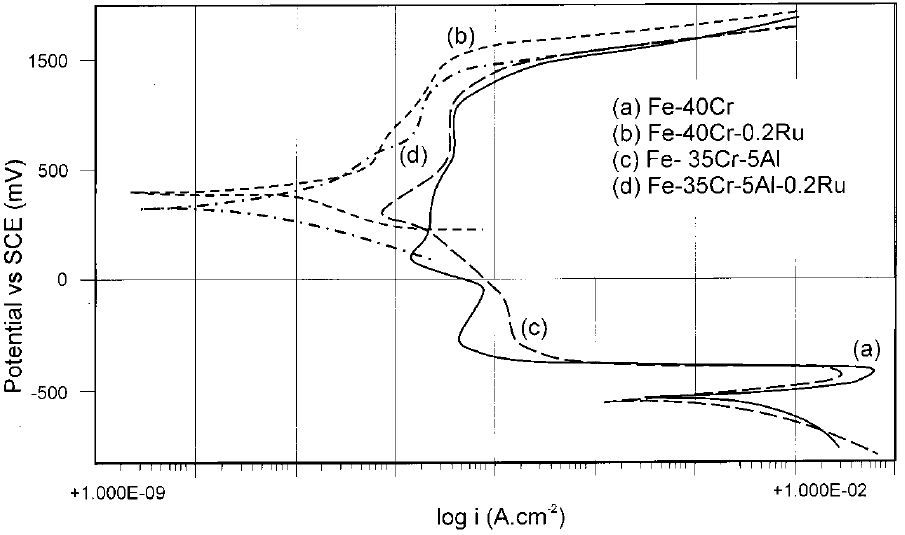
Figure 7. Potentiodynamic scans in 10% H 2 SO 4 at 25 °C of Fe-40Cr alloy in comparison to an alloy where Cr is partially substituted by Al (Fe-35Cr-5Al) and the other two alloys where both are modified by micro-addition of Ru (0.2%) (reprinted from [75] with permission of Elsevier).